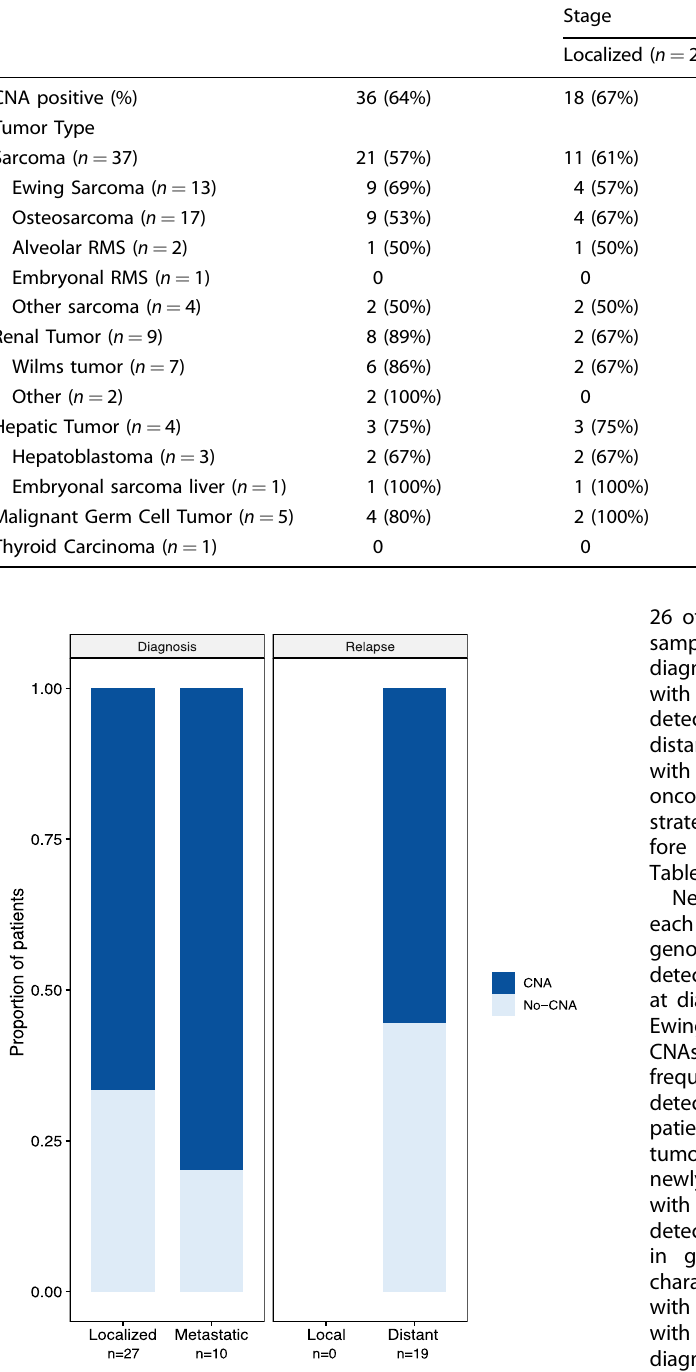
Fig. 1 Copy number alteration detection in liquid biopsies of pediatric solid tumor patients. Summary of copy number alteration (CNA) detection and disease status at initial diagnosis and relapse in treatment naïve patients (i.e., no de fi nitive surgery, radiation, or chemotherapy). CNAs were detected in the plasma from 18 of 27 (67%) and eight of 10 (80%) newly diagnosed patients with localized disease and metastatic disease, respectively. CNAs were detected in the plasma of 10 of 19 (53%) patients with distant recurrence of the disease. Dark blue- CNA positive, Light blue- CNA